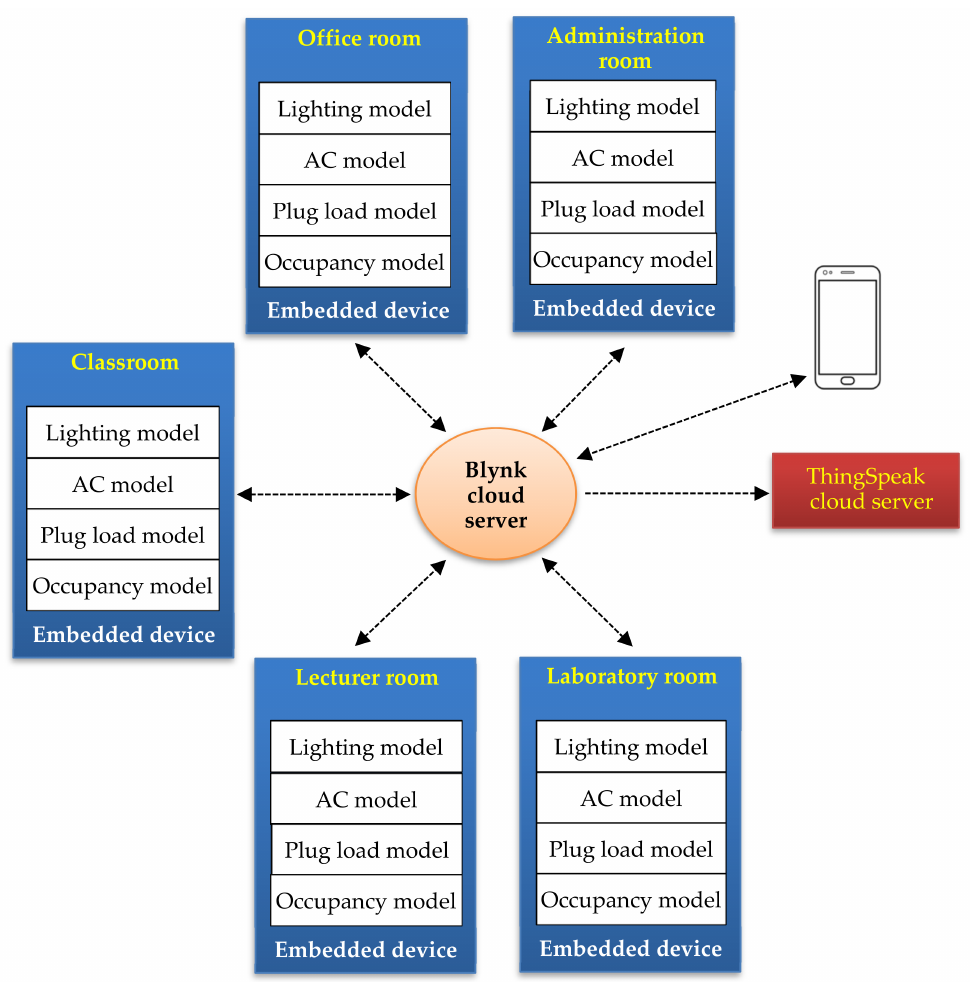
Figure 2. Architecture of proposed